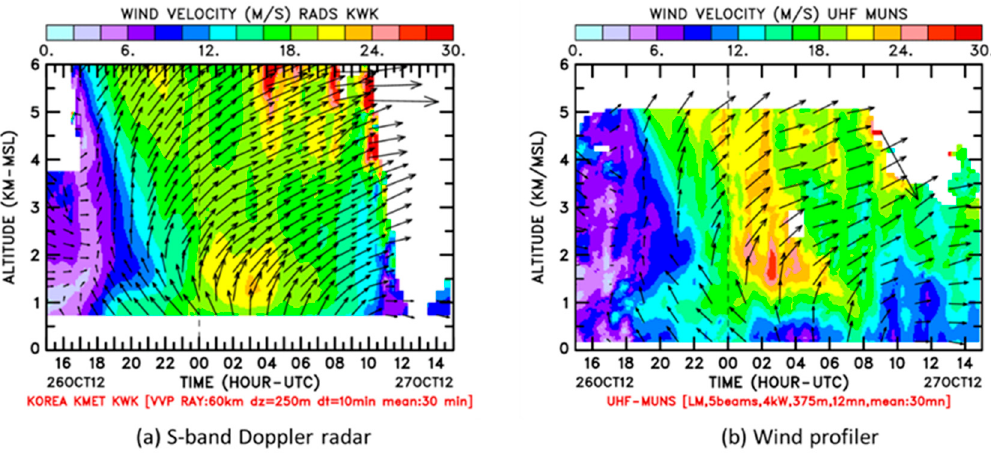
Figure 14. Comparison of the horizontal wind fields ( a ) from the S-band radar near R5 with those ( b ) from the WPR at P4 on 26–27 October 2013.